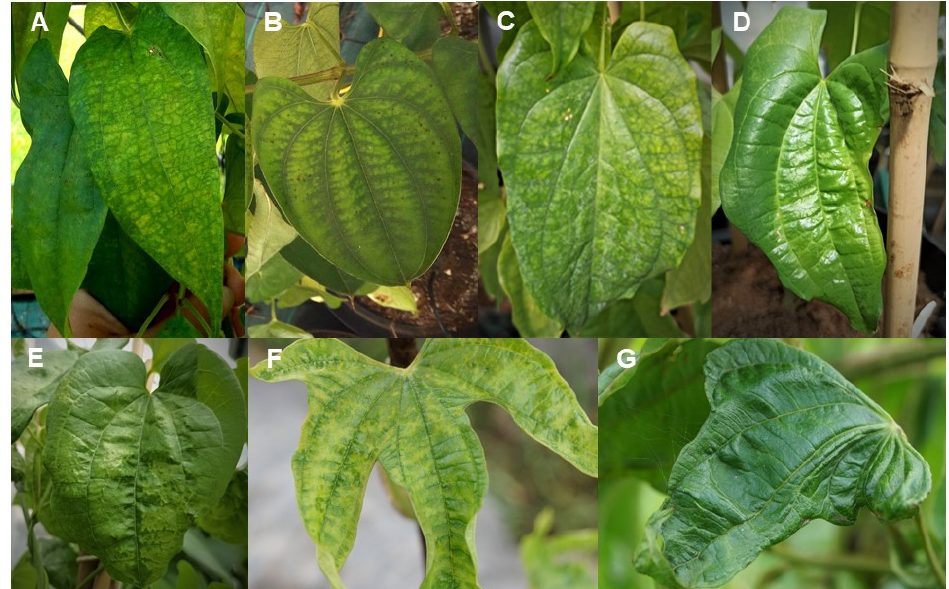
Figure 1. Examples of some v iral symptoms observed on yam leaves. ( A ) Mosaic and leaf deformation on D. alata ‘sweet yam’; ( B ) Chlorosis on D. alata ‘Roujol’; ( C ) Mosaic on D. rotundata ‘Pouna’; ( D ) Mottling and leaf distortion on D. rotundata ‘TDr 07/00033 ′ ; ( E ) Puckering on D. rotundata ‘TDr 07/00033 ′ ; ( F ) Mosaic on D. trifida ‘Amoumbé 1 ′ ; ( G ) Severe leaf deformation on D. trifida ‘Praïnia’. Photographs courtesy of INRAE ( A , B , F , G ) and NRI ( C , D , E ).